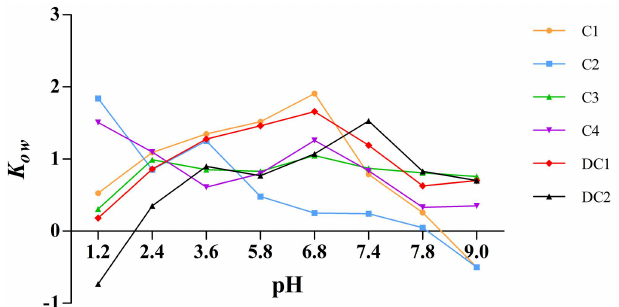
Figure 7. K ow –pH profiles of C1, C2, C3, C4, DC1, and DC2. The equilibrium partition of the six saponins monomers between n -octanol and different pH values of phosphate buffer (pH 1.2, 2.0, 3.6, 5.8, 6.8, 7.4, 7.8, and 9.0) was determined by the traditional shake-flask method coupled with validated HPLC quantification